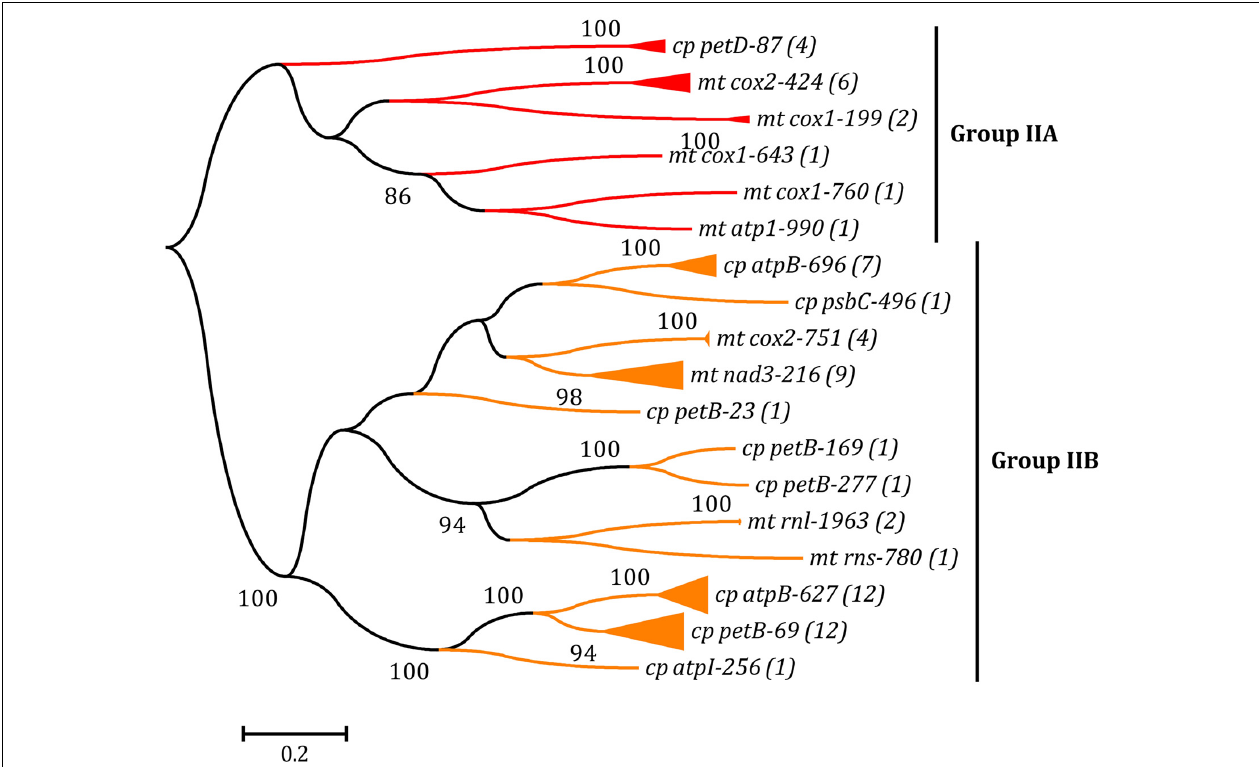
FIGURE 4 | Phylogenetic tree based on Maximum Likelihood (ML) analysis of amino acid (aa) sequences of 67 reverse transcriptase (RT) domains (40 in cpDNAs and 27 in mtDNAs) from group IIA and IIB introns. The ML analysis was conducted with 1,000 bootstrap replicates using MEGA 7.0. The bootstrap support values greater than 80% were displayed at branches. Branch lengths were proportional to the amount of sequence change, which were indicated by the scale bar below the trees. The numbers in parentheses represented the number of RTM proteins from cognate introns. The complete phylogenetic tree was shown in Supplementary Figure 2